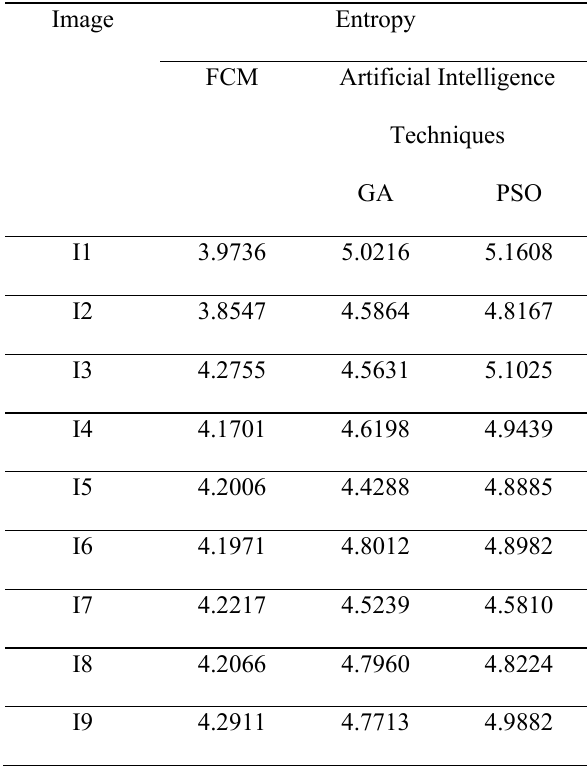
Table 3. Entropy for FCM, GA and